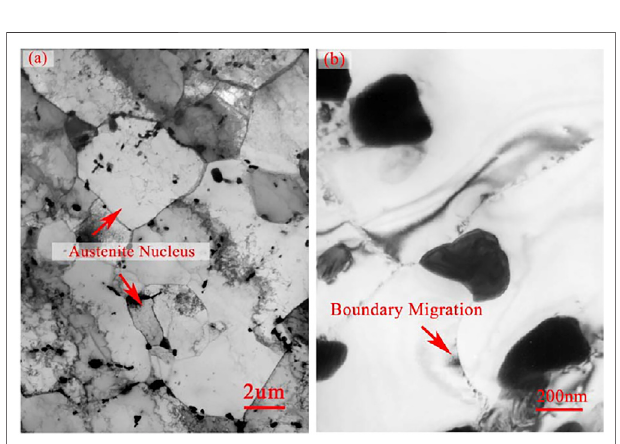
FIGURE 5 | TEM images of NSM steels heated at 770 ° C for 90 min (A) austenite nucleus in degenerated martensite. (B) martensite grain boundary migration retarded by the